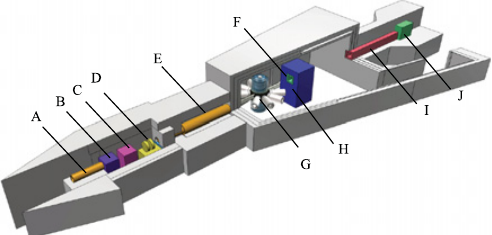
Figure 3. The schematic view of ANNRI beam line [15]. (A) Collimator, (B) T 0 -chopper, (C) Neutron filter, (D) Disk chopper, (E) Collimator, (F) Iron, (G) Germanium detector assembly, (H) Concrete, (I) Boron resin, and (J) Beam stopper (Iron).